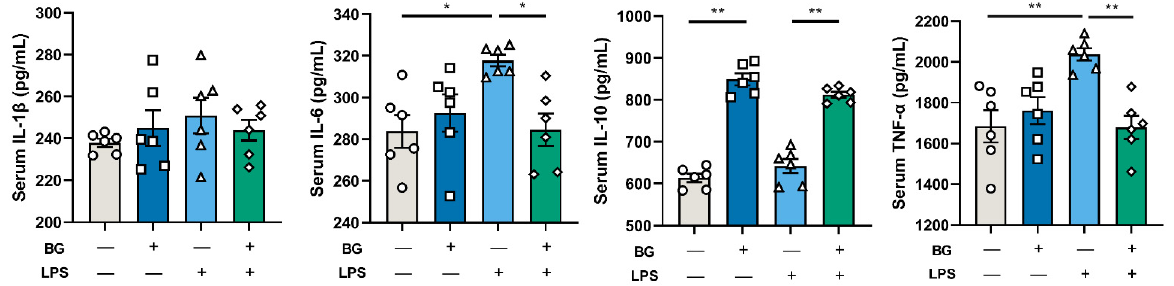
Figure 8. BG administration regulated the inflammatory responses of LPS-stimulated mice. Data are presented as mean ± SEM, n = 6. “+” and “ − ” mean with and without corresponding treatments, respectively. * and ** indicate significant difference ( p < 0.05 and p < 0.01, respectively). An unpaired t -test was used for statistical analysis between two groups.